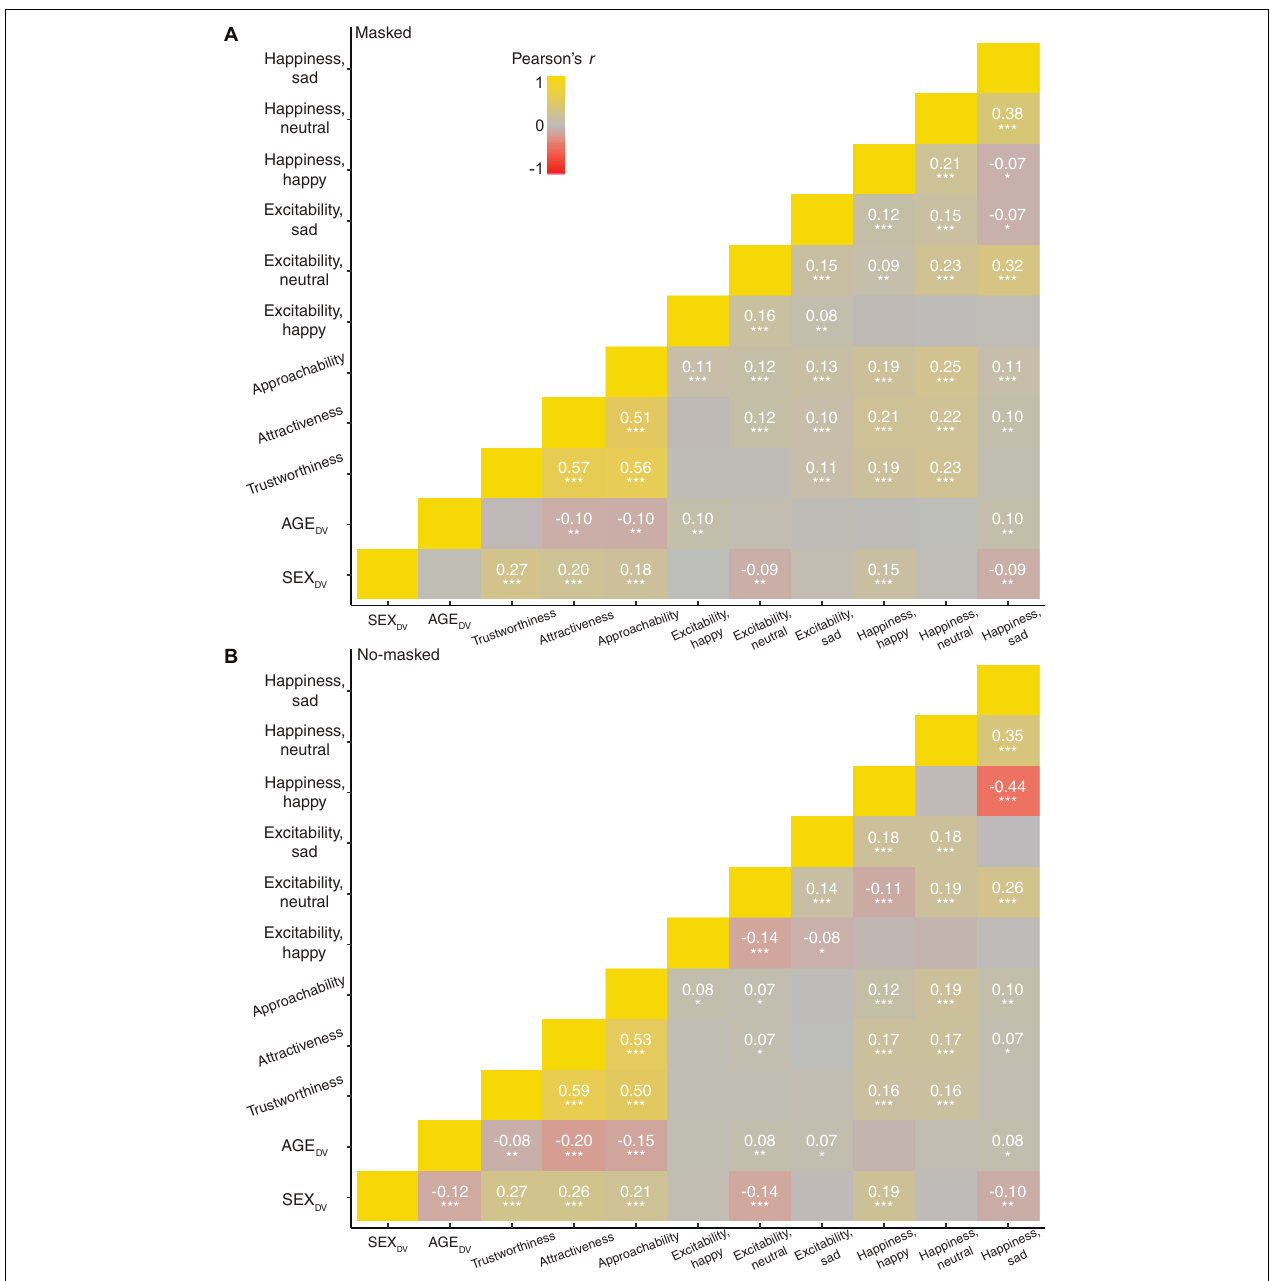
FIGURE 5 | Correlations between dependent variables for (A) masked and (B) no-masked faces. Color indicates correlation coefficient; Pearson’s r . Non-significant coefficients were excluded to reduce visual clutter. *** p ≤ 0.001, ** p ≤ 0.01, * p ≤ 0.05.